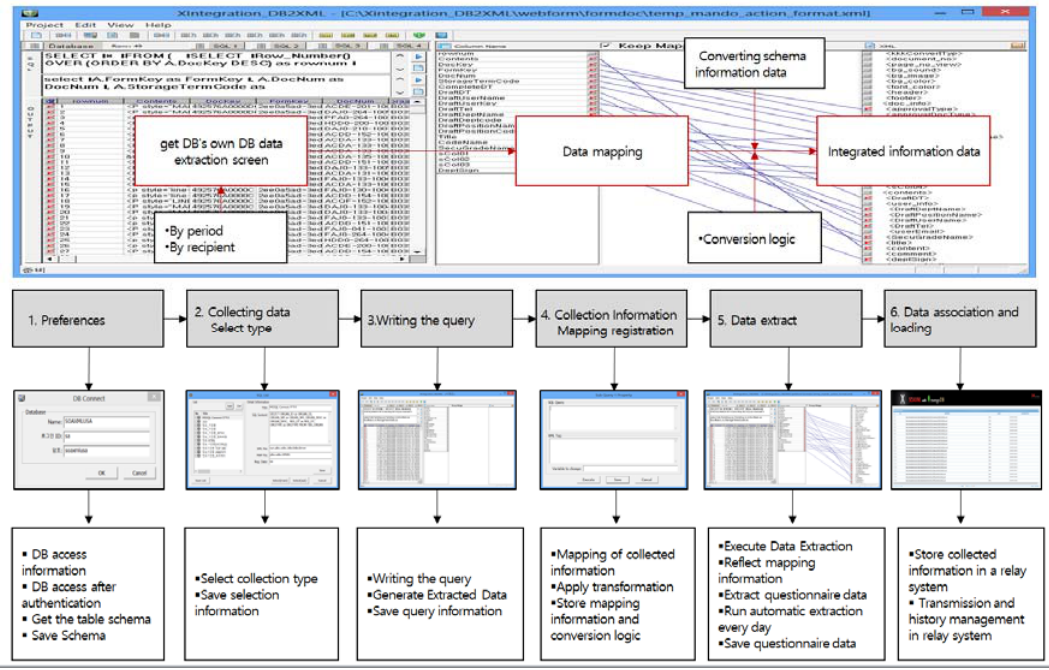
Figure 23. Rainbowchain data mapping method.